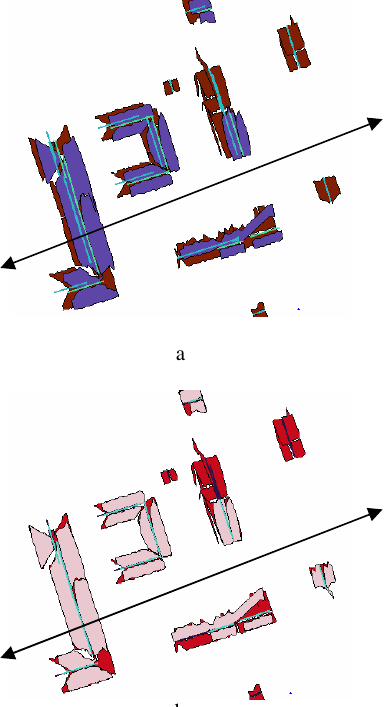
Figure 5. Roof separation before (a) and after (b) “First Case” rectification. The double arrow indicates that the area was